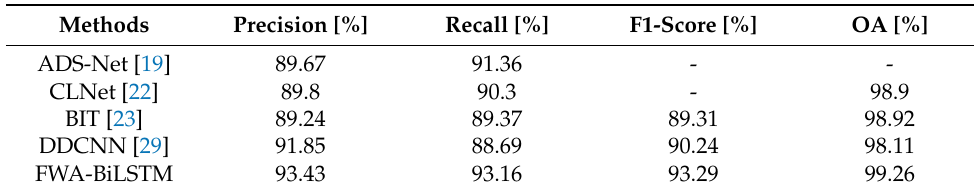
Table 8. Comparative analysis on LEVIR-CD dataset.